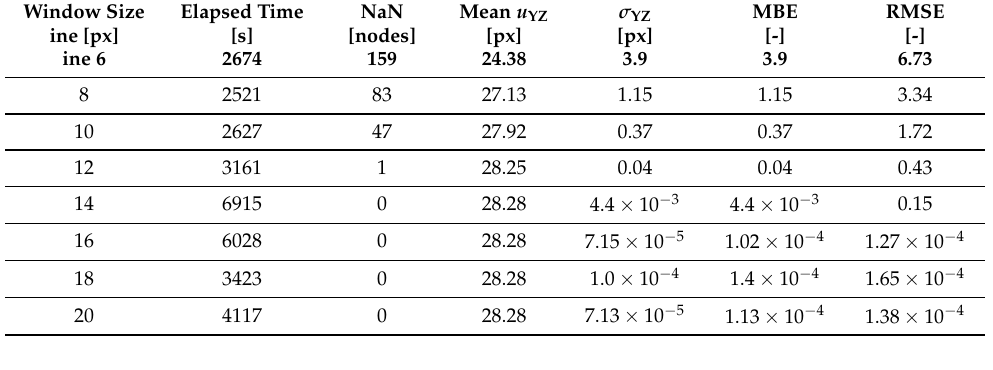
Table 1. The results of the determination of the optimal correlation window size. NaN indicates the number of nodes, where the unconverged solution occurred, the value of the standard deviation σ YZ shows the error from the ideal displacement u YZ given by the length of the motion vector √ ( 20 2 + 20 2 = 28.2842) in the YZ plane.